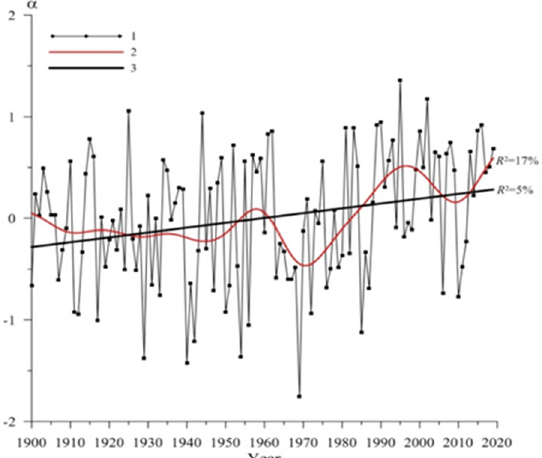
Figure 6. Long-term change in the integral indicator of winter anomaly ( α ) averaged over the Volga Federal District. 1—initial series; 2—LFC with a period of more than 10 years; 3—linear trend.